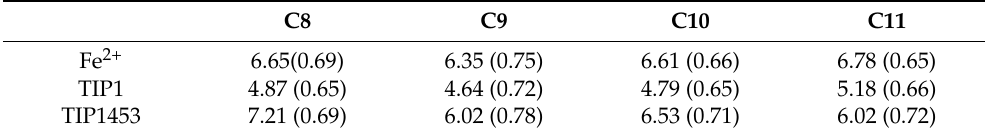
Table 3. Average bond distances in Å with the corresponding standard deviation of the carbons 8, 9, 10 and 11 of β -carotene to Fe 2+ , and to water molecules TIP1 and TIP1453, for